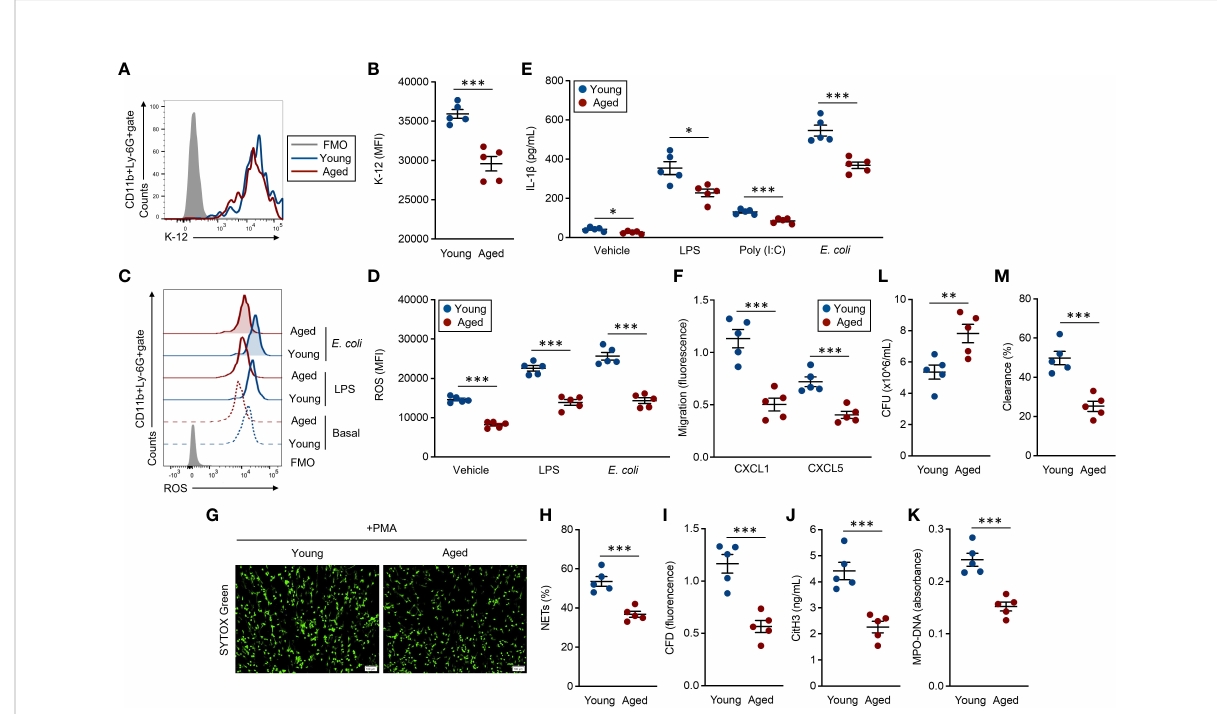
FIGURE 3 Functional impairment of aged mouse neutrophils (A, B) Phagocytosis assay against the E. coli K-12 strain. Neutrophils (1.0 × 10 7 /ml) were incubated with E. coli K-12 BioParticles (FITC labeled, 10 m g/ml) at 37°C for 2 h. The signal of the incorporated K-12 was detected by fl